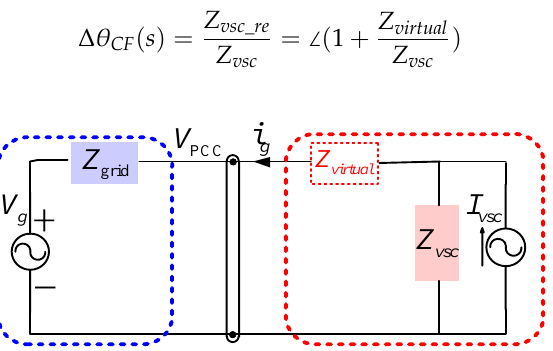
Figure 3. Equivalent circuit of VSC system after impedance reshaping.